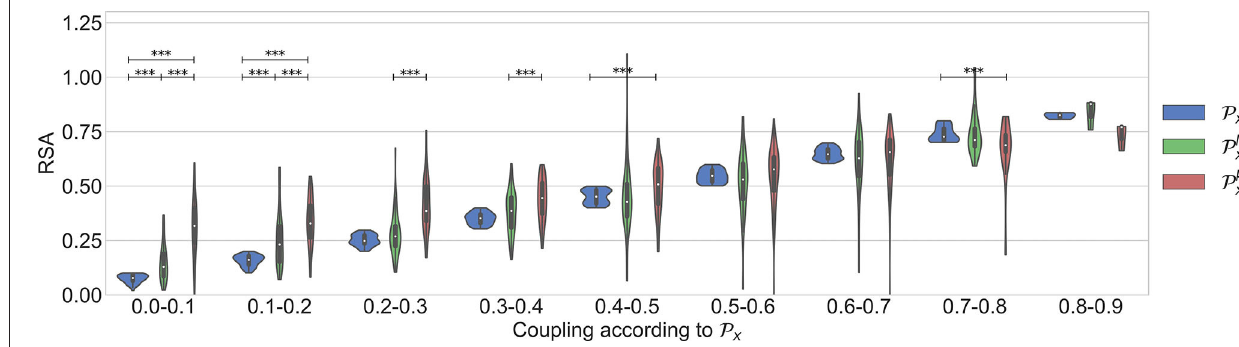
FIGURE 5 | Results using the dataset of segments with apneas.